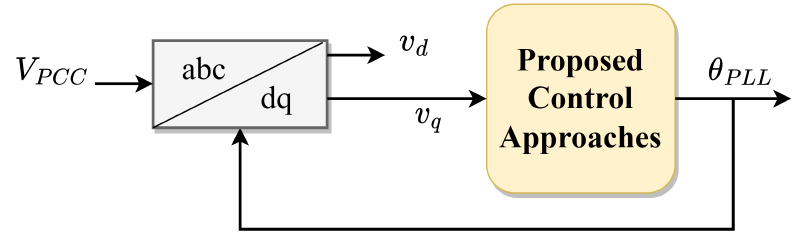
Figure 13. General control diagram of PLL .